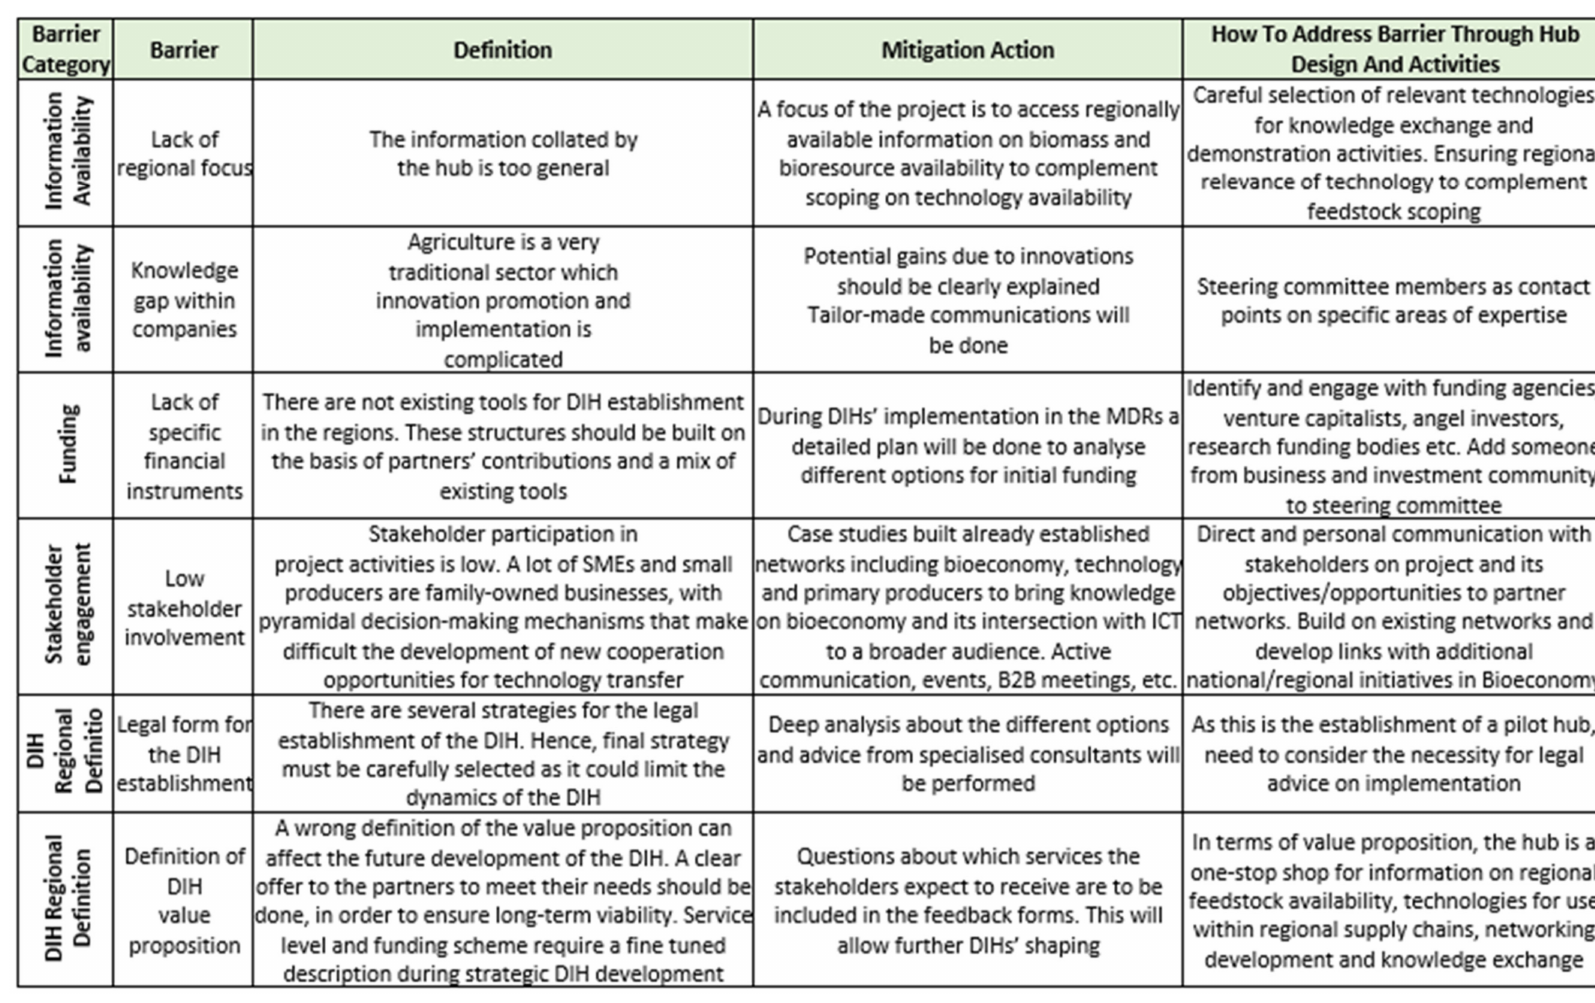
Figure 4. Barriers Mitigation